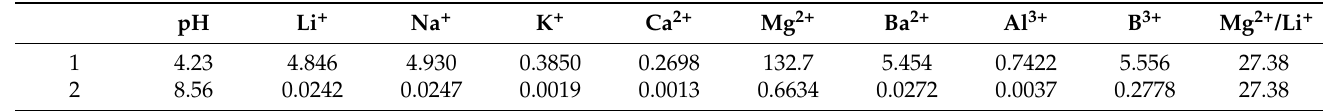
Table 2. The pH and composition of the salt lake brine (1) and diluted salt lake brine (2) (g · L − 1